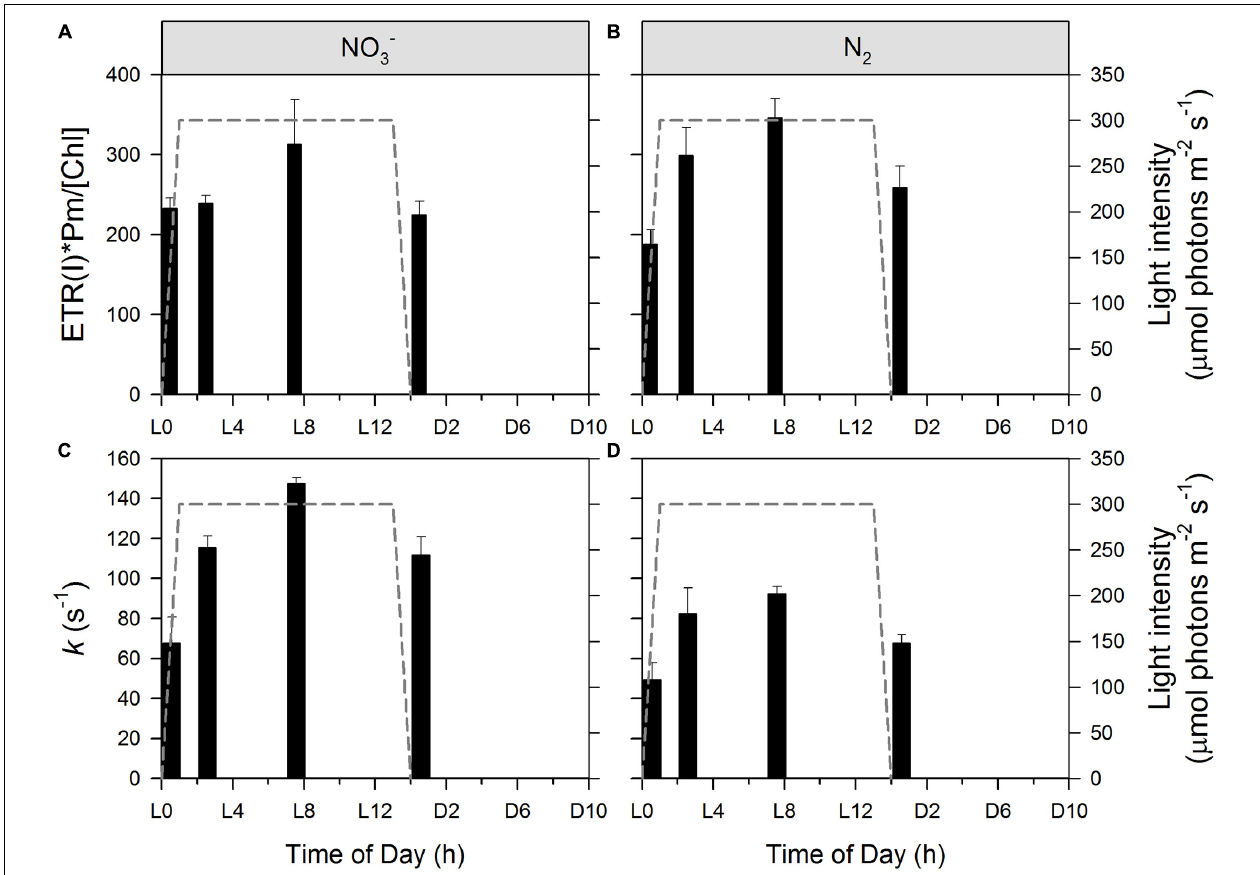
FIGURE 6 | Dynamics of PSI-mediated electron flow [ETR(I)] during Cyanothece cultivation in ASP 2 medium supplemented with NO 3 − (A,C) and under obligate diazotrophy (B,D) . Raw ETR(I) values were normalized according to Pm values and Chl a concentration (A,B) . k represents the rate constant for re-reduction of P 700 by intersystem electrons after a flash (C,D) . Data represent averages from 3 replicates, with error bars representing standard